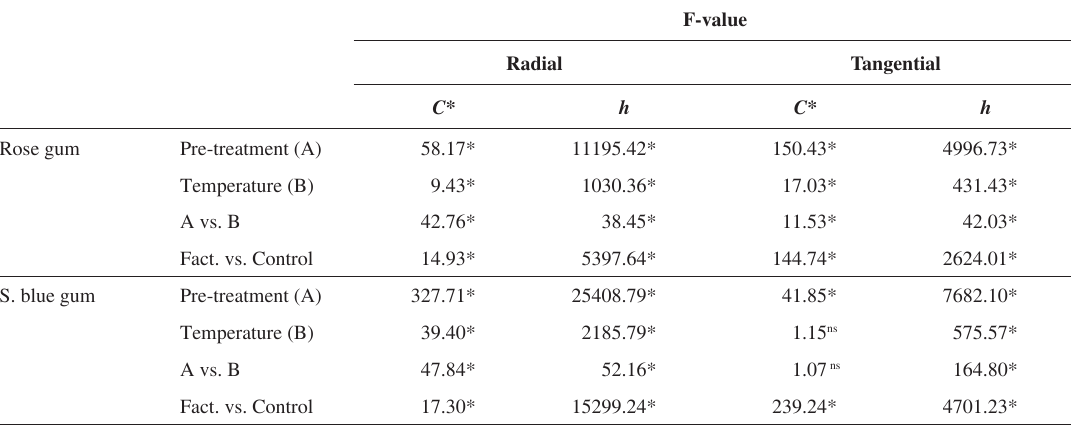
Table 3. Summary of factorial analysis of variance with additional treatment for the parameters C* and h in radial and tangential direction of rose gum and Sydney blue gum wood.